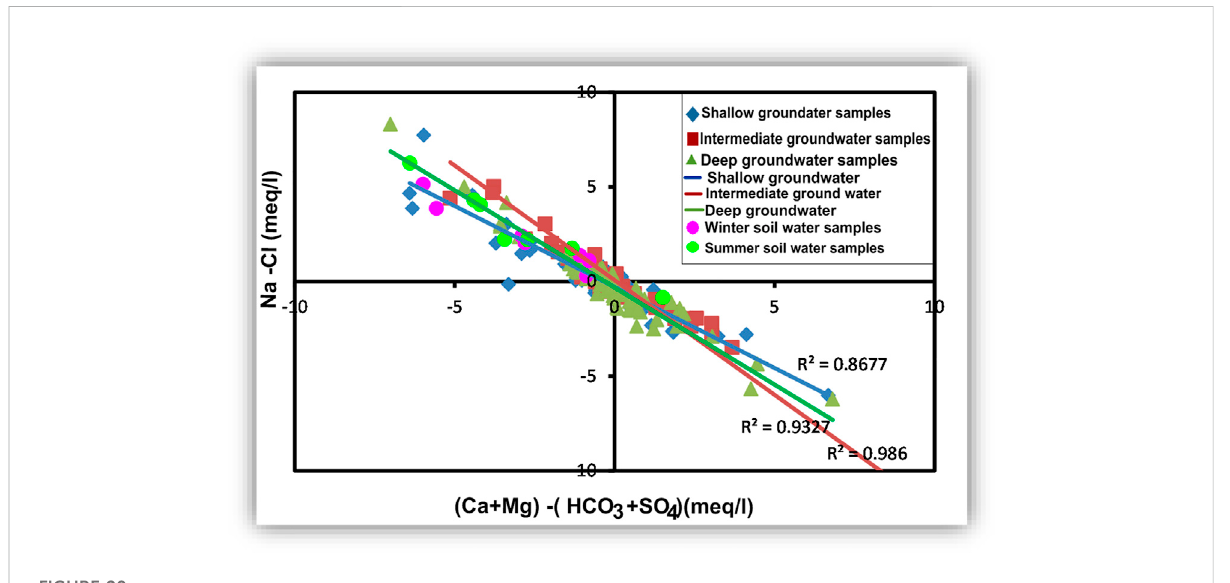
FIGURE 20 Binary diagram illustrates the ion exchange processes in the